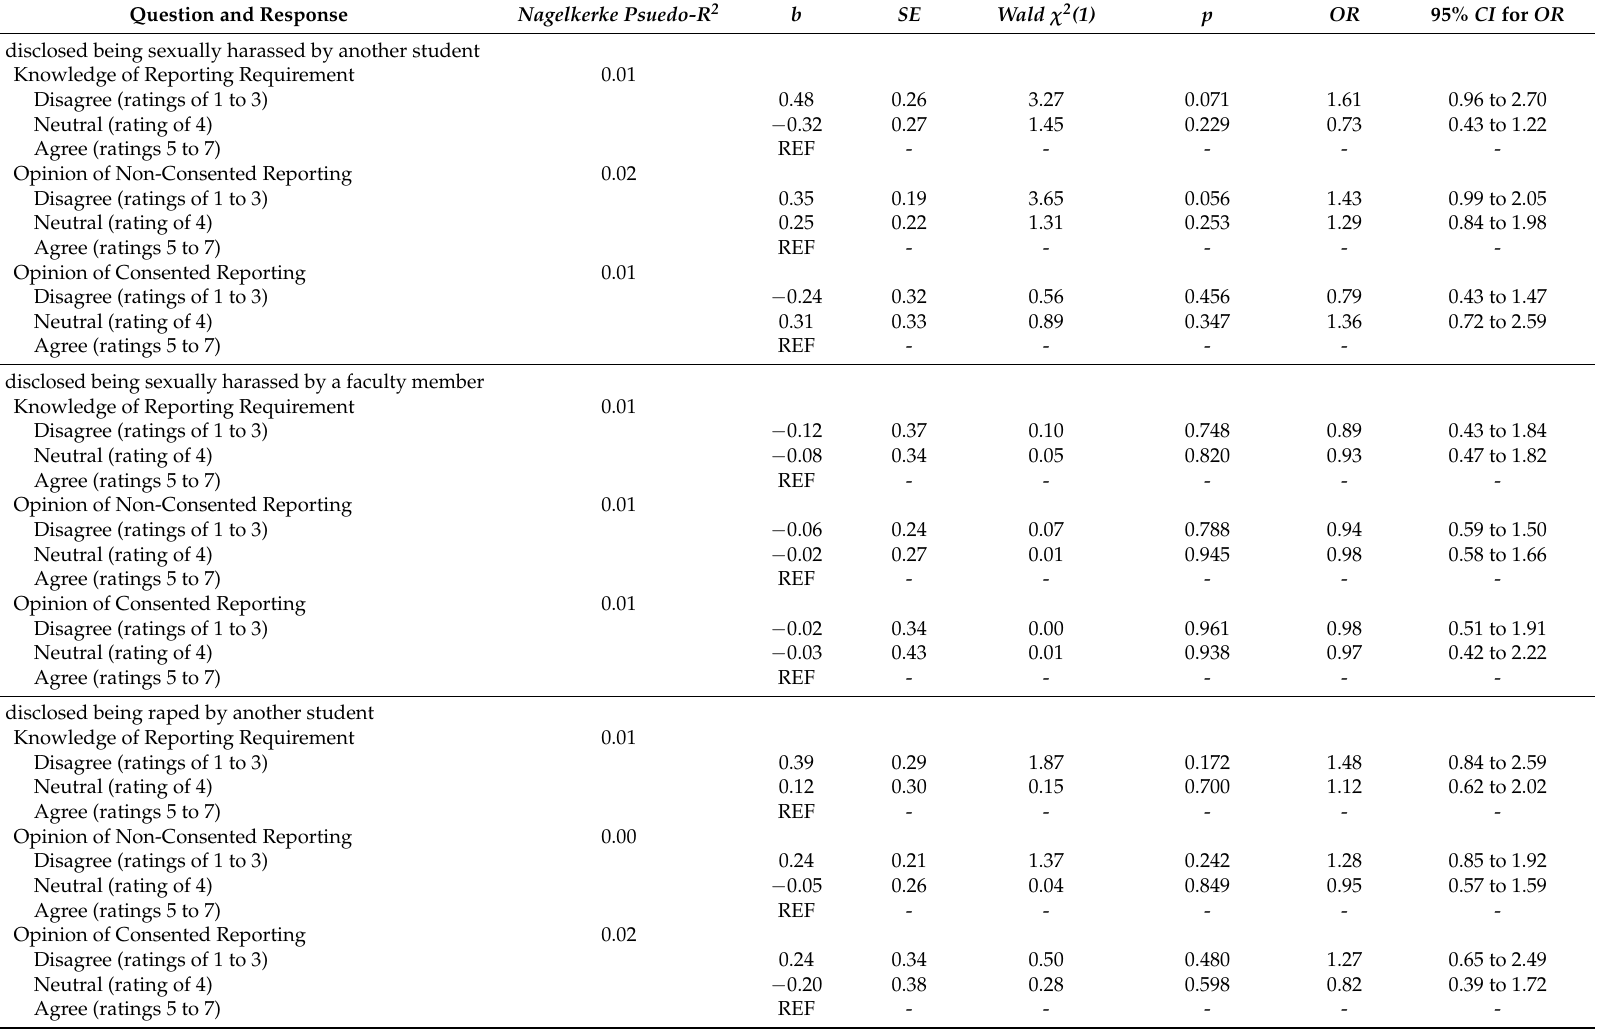
Table 4. Results of multinomial logistic regressions examining the effect of sexual assault history on responses to Title IX questions (student sample; N = 783). Question and Response Nagelkerke Psuedo-R 2 b SE Wald χ 2 (1) p OR 95% CI for